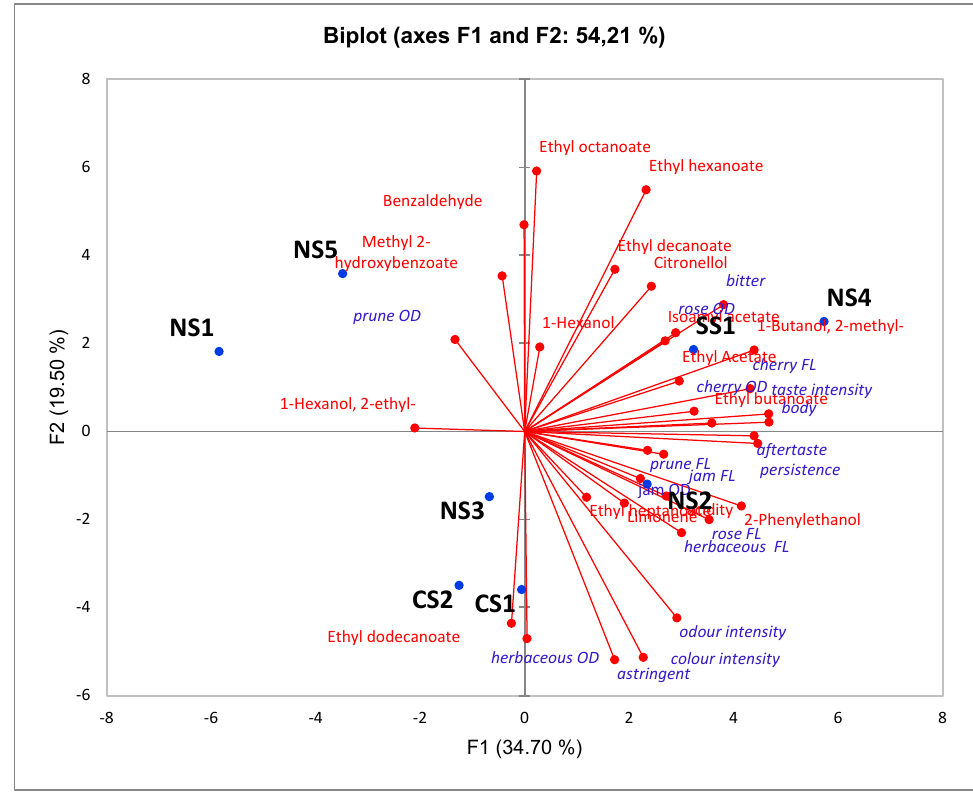
Figure 2. Principal component analysis (PCA) biplot for volatile organic compounds (VOCs) detected by GC-MS and sensory attributes. NS1-5 wines = north Sardinia; CS1-2 wines = central Sardinia; SS1 wine = south Sardinia. Sensory attributes followed by OD represent olfactory attributes, while sensory attributes followed by FL represent flavor attributes.